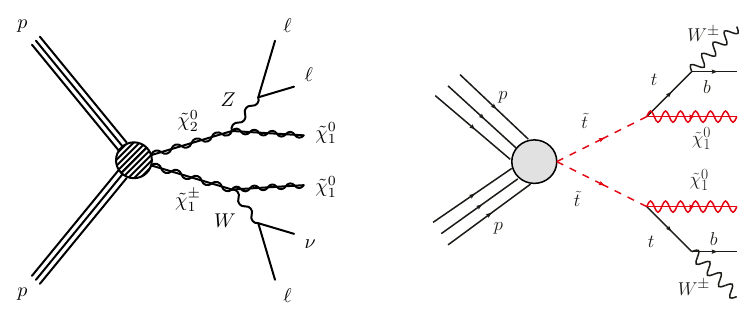
Figure 1. Feynman diagrams of the simplified supersymmetric models considered in (left) the prototype electroweakino analysis and (right) the prototype stop pair